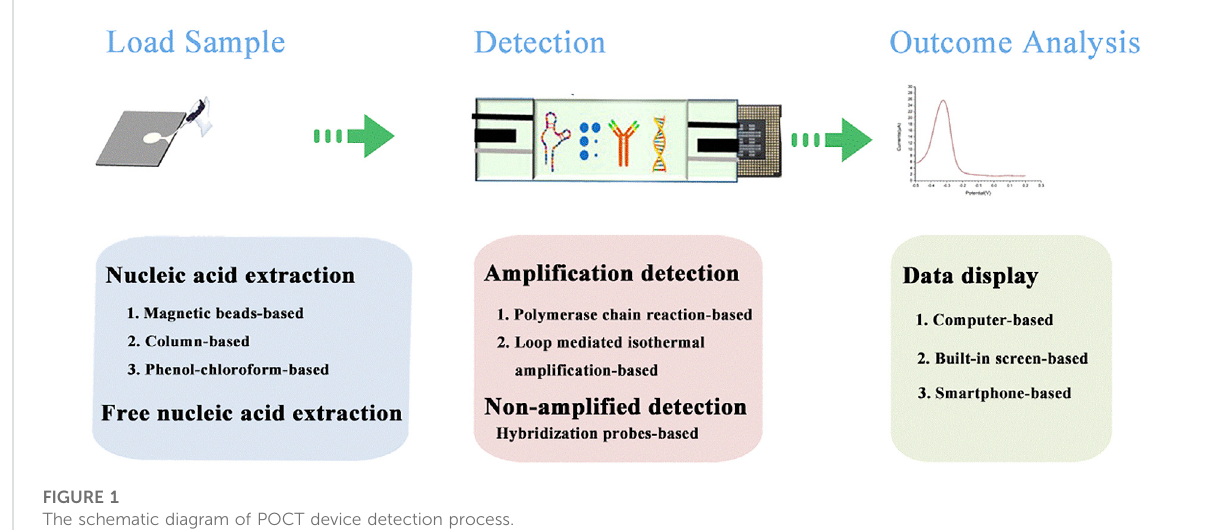
FIGURE 1 The schematic diagram of POCT device detection process.